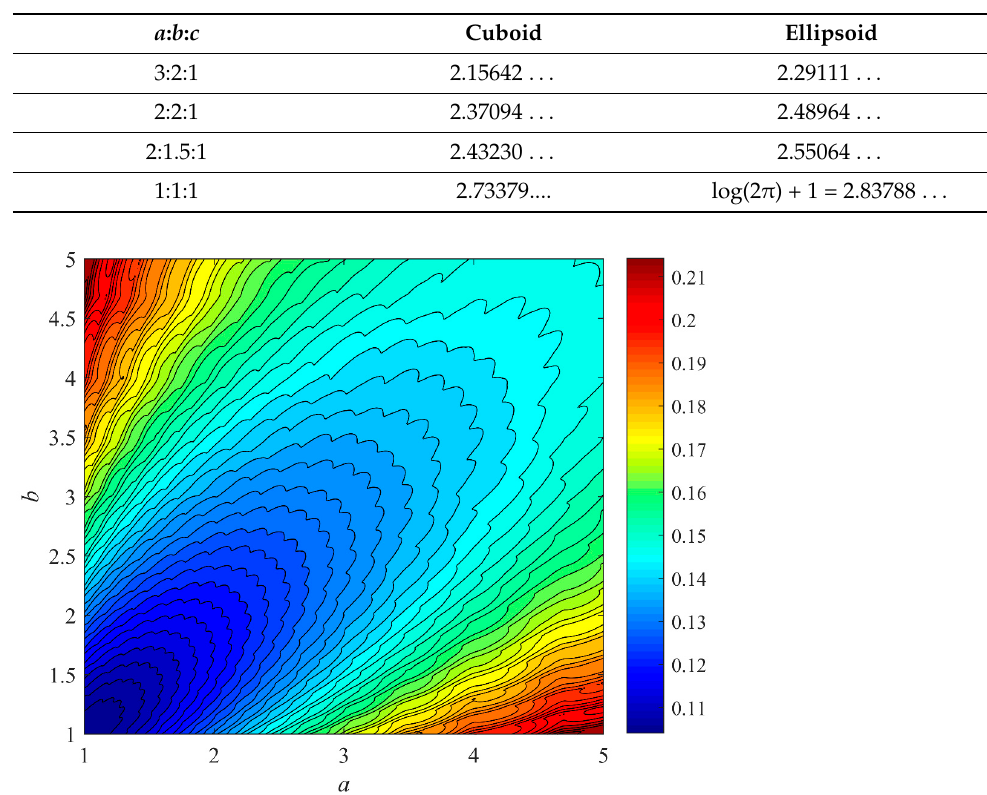
ratios. The blue area suggests less difference. Since it is assumed that c = 1 for all shapes shown,